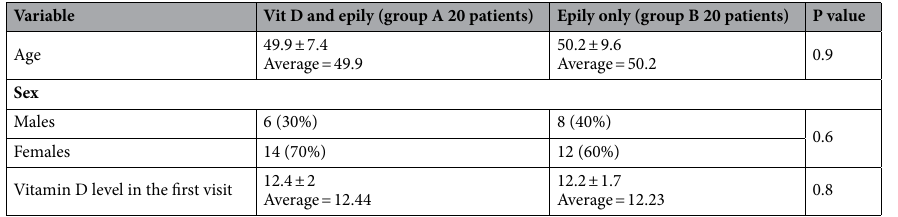
Table 1. Comparison between demographic data of both groups.